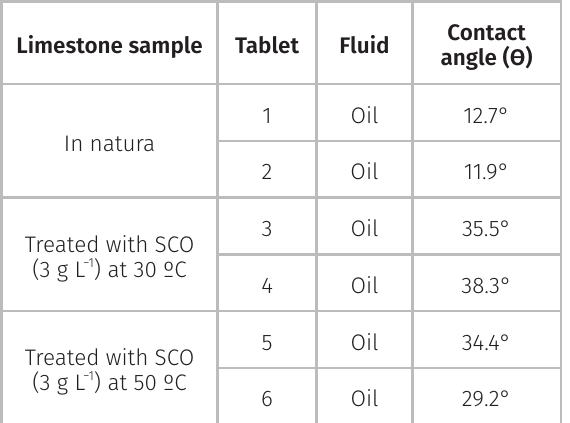
Table IV. Contact angle data for tablets made with in natura and SCO-treated limestone at 30 ºC and 50